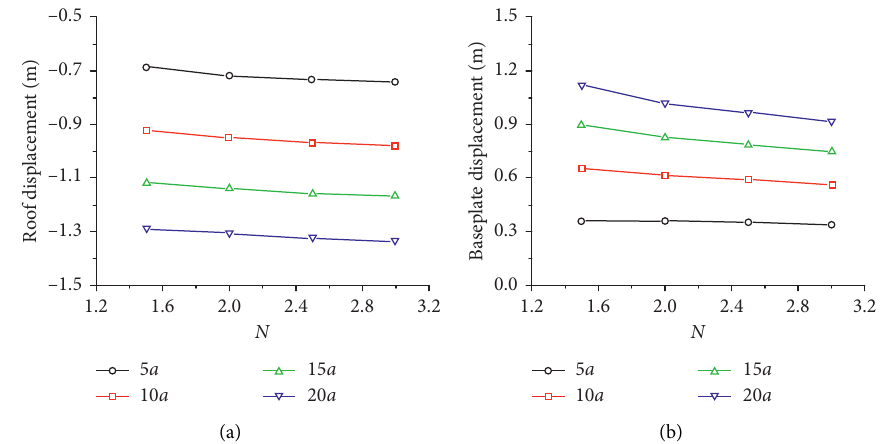
Figure 7: Variation of the maximum vertical displacement of point p and point q of a single-cavern horizontal salt rock underground storage with the diameter-to-height ratio. (a) Roof displacement. (b) Floor displacement.